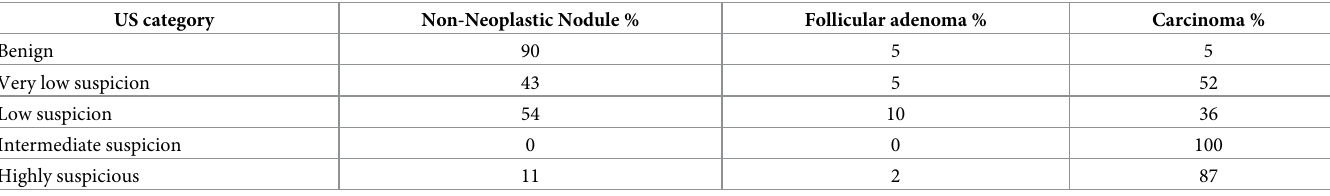
Table 4. Correlation between ultrasonographic category and risk of